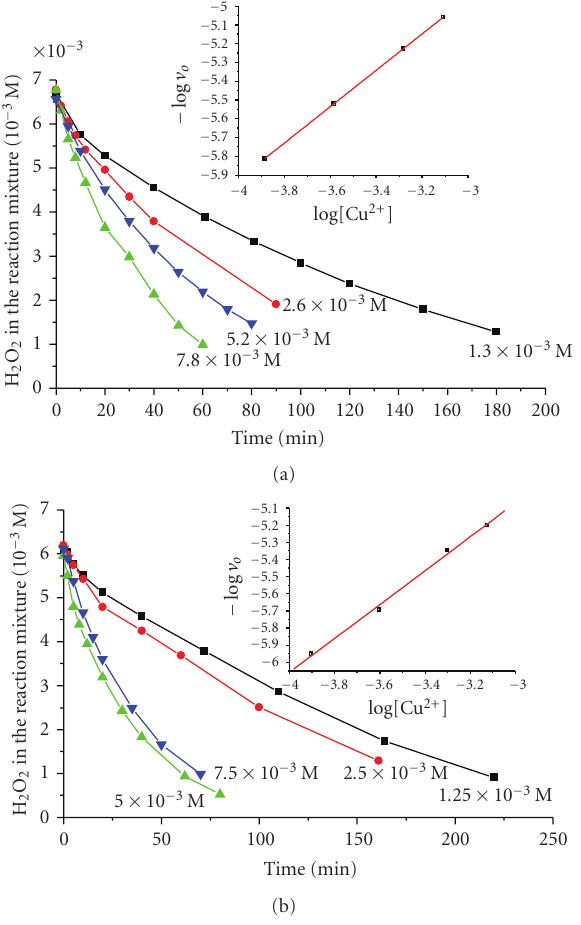
Figure 2: The variation of [H 2 O 2 ] in the reaction mixture (% of the initial concentration) versus time for di ff erent Cu(II) concentrations, and (insert) logarithm of the initial rate ( v o ) versus logarithm of the [Cu(II)] for the system (a) PAla-Cu(II), R = [PAla] / [Cu(II)] = 4, initial concentration [H 2 O 2 ] = 6 . 8 × 10 − 3 M, pH = 8.5, T = 298 K. (b) PGlygly-Cu(II), R = [PGlygly] / [Cu(II)] = 4, initial concentration [H 2 O 2 ] = 6.2 × 10 − 3 M, pH = 8.9, T = 298 K.